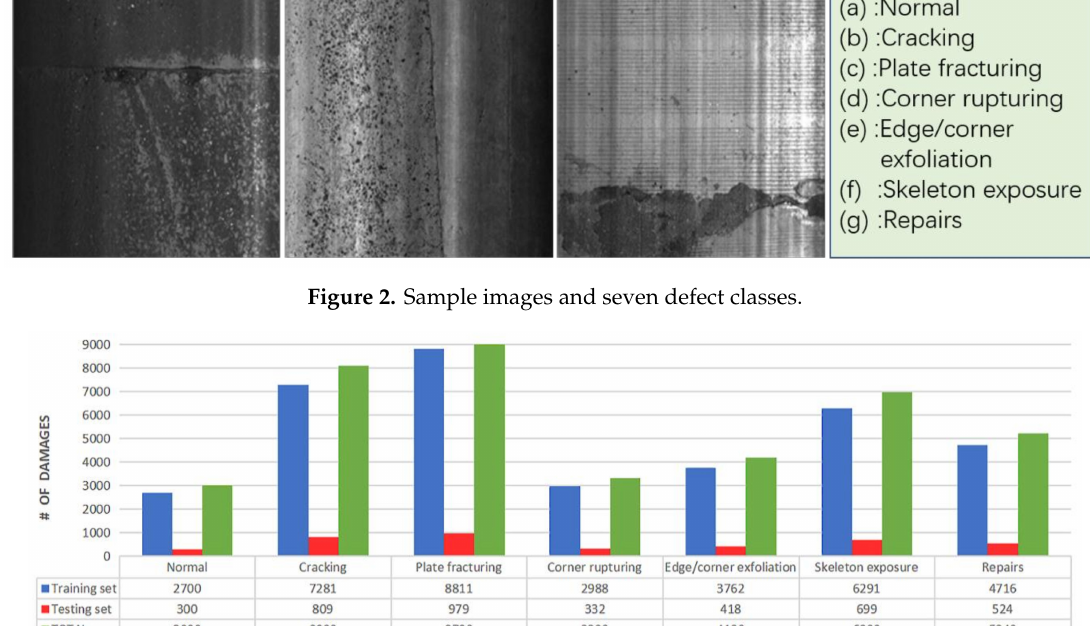
Figure 3. Number of images in each defect